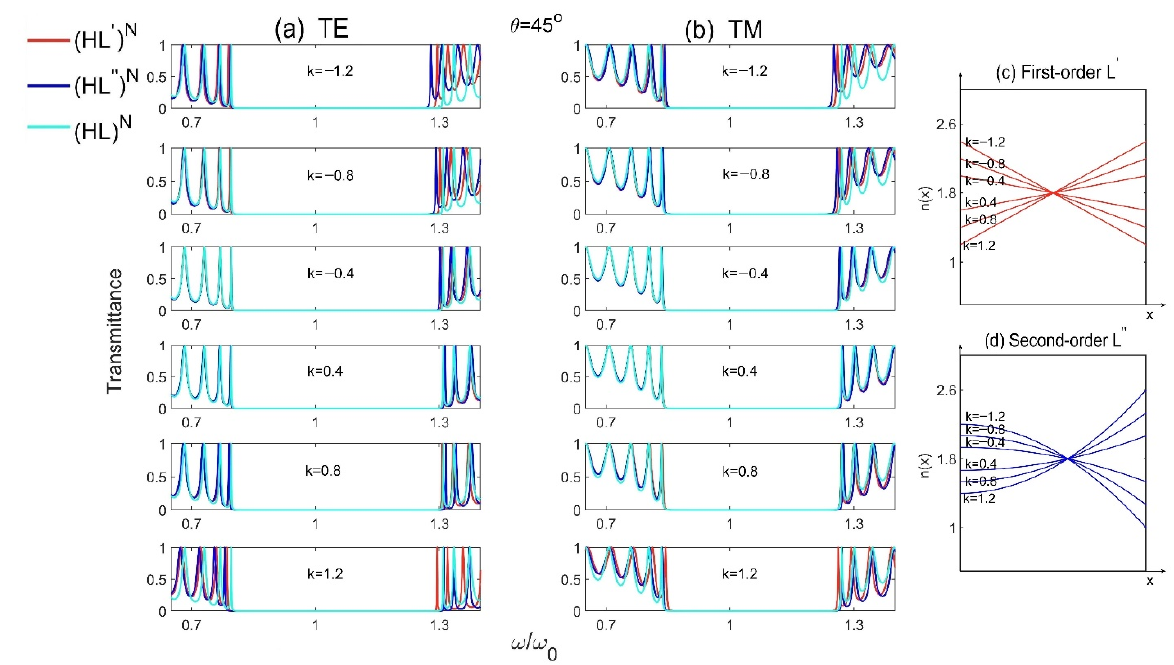
Figure 7. Field distributions for ω = 1.2 ω 0 and k = − 0.4 at incident angle θ = 0 ◦ for ( a ) Model 3 ( HL (cid:48) ) N , ( b ) Model 4 ( HL (cid:48)(cid:48) ) N and ( c ) reference Model ( HL ) N , respectively.